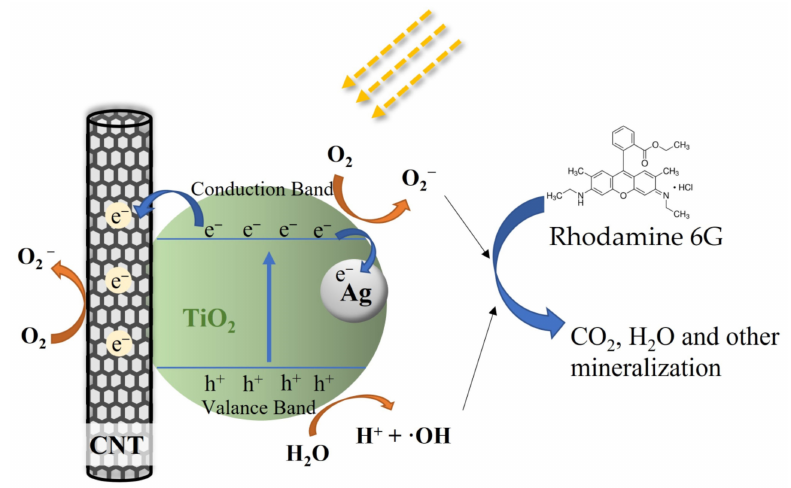
Figure 11. Possible schematic explaining the photocatalytic activity of the T-C-A ternary